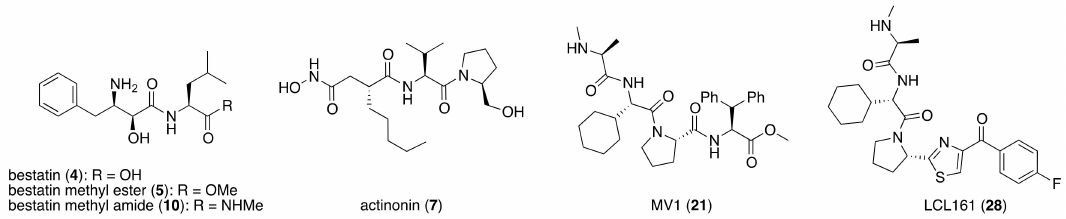
Figure 1. Chemical structures of small-molecular cIAP1